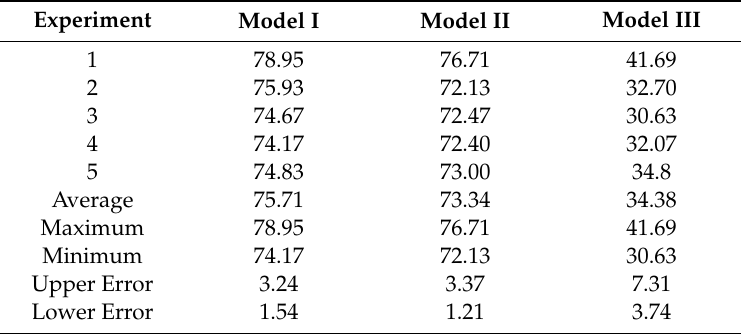
Table 4. The tensile strength (N / mm 2 ) of three models for each test.